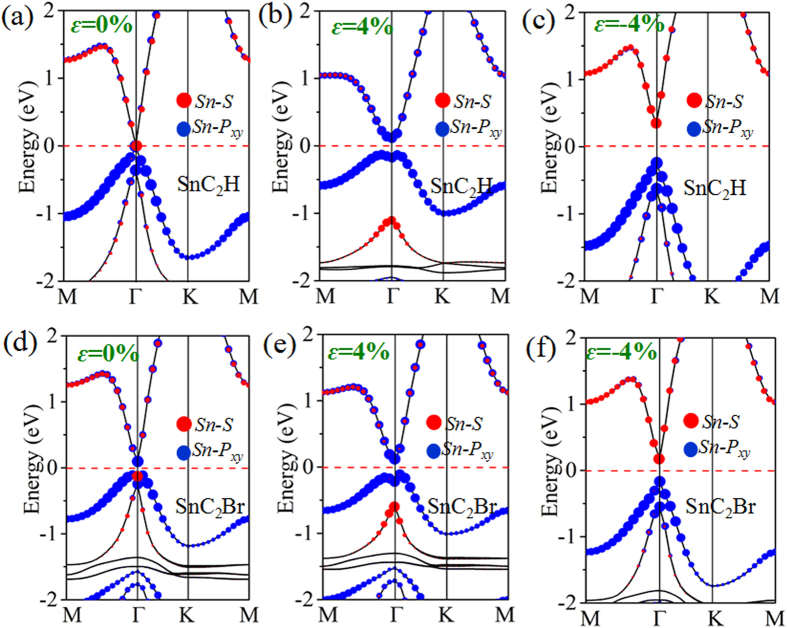
Orbital-resolved band structures with SOC of SnC2H (a–c) and SnC2Br (d–f) under biaxial strain ε = 0%, 4% and −4%, respectively.The red dots represent the contributions from the s atomic orbital of Sn atom and the blue dots represent contributions from the px and py atomic orbitals of Sn atom.